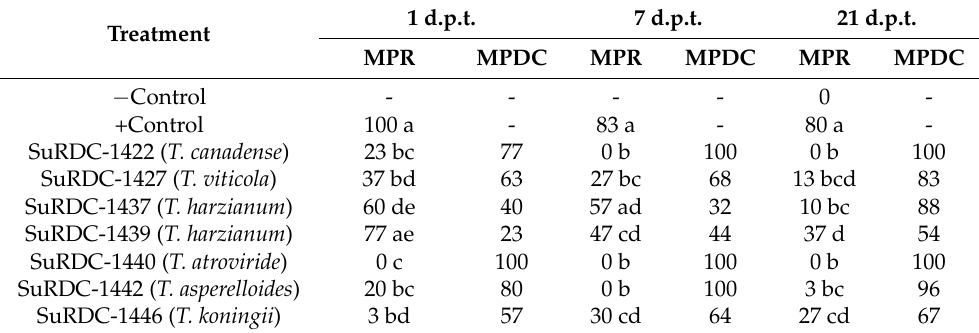
Table 4. Efficacy of Trichoderma isolates from BC applied immediately after pruning, followed by inoculation of 5000 conidia of N. parvum 1 day, 7 days, and 21 days post-treatment in a detached cane assay